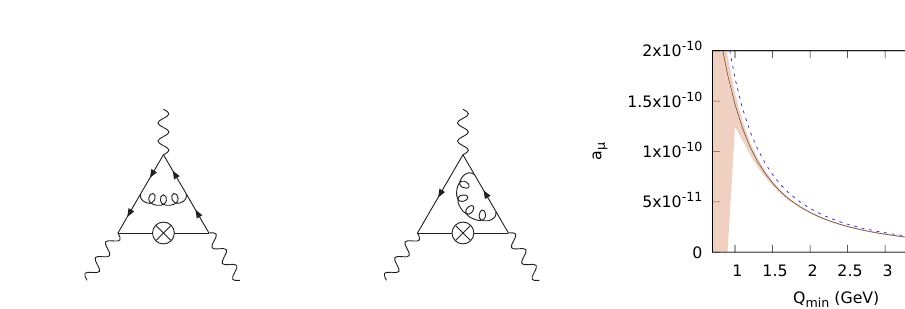
Figure 7. Contributions to a HLbL from gluonic cor- µ rections to the perturbative quark loop. The uncer- tainty band is associated to α s ( µ = Q min